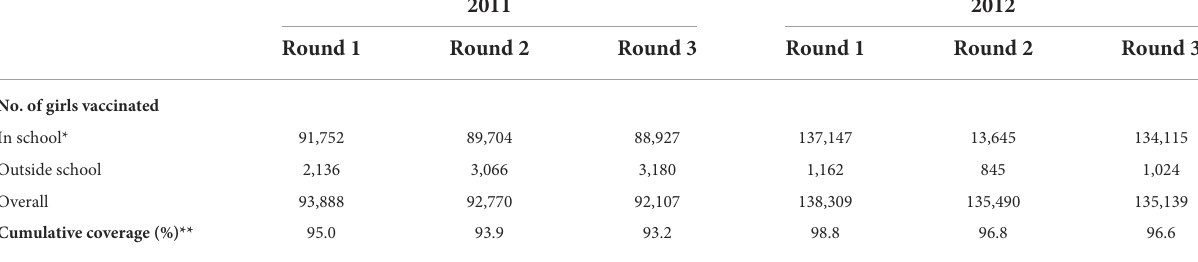
TABLE 4 HPV vaccination coverage in Rwanda,